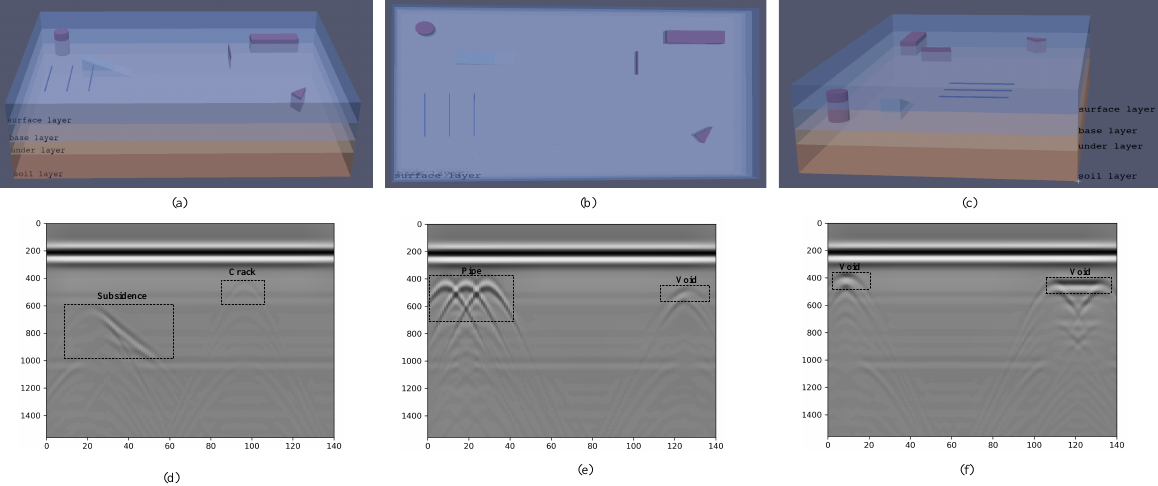
Figure 10. Simulation results of the airport runway subsurface model. ( a – c ) Different view of the simulated airport runway model with subsurface defects. ( d – f ) Simulated GPR B-scan images.